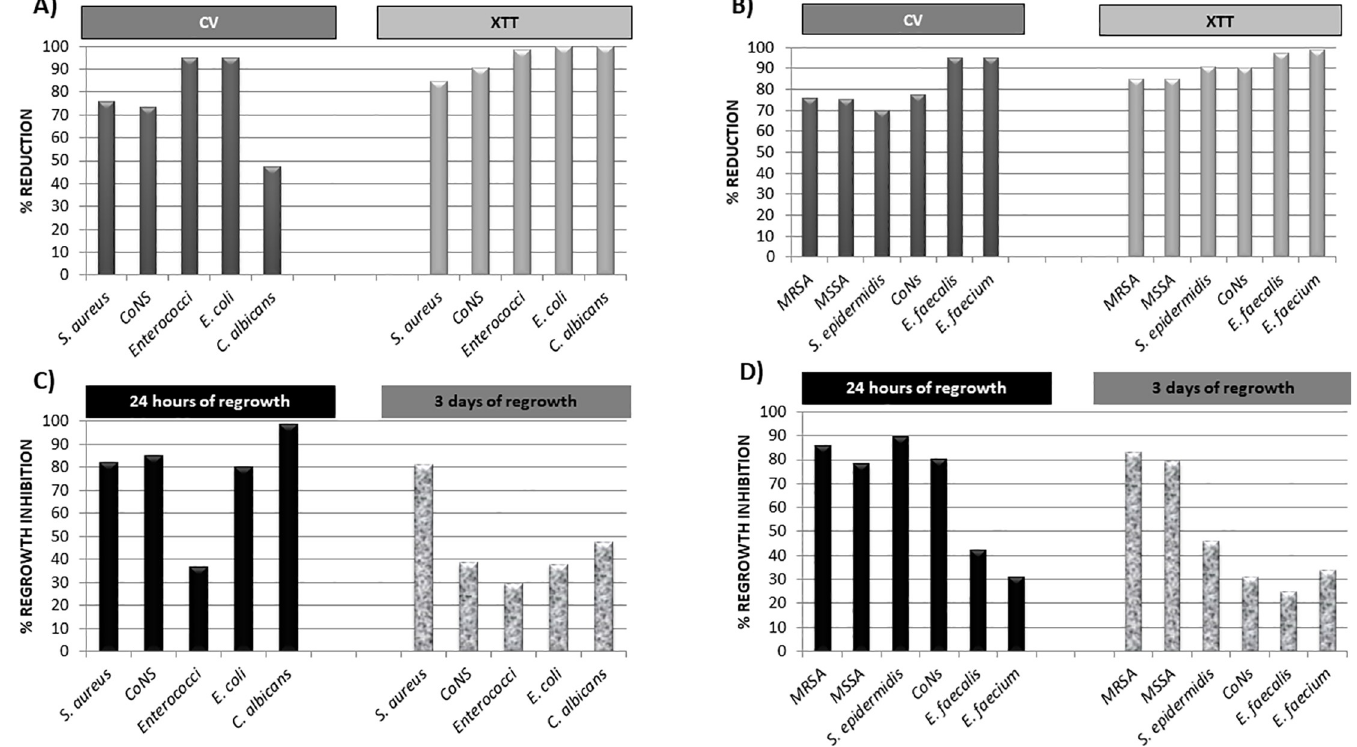
Fig 1. Percentage reduction of biomass and metabolic activity and percentage of regrowth inhibition of biofilms after 72-hour treatment of 40% ethanol combined with 60 international units (IU) of heparin. A) Overall percentage reduction in biomass and metabolic activity after 72-hour treatment with heparinized 40% ethanol lock solution. B) Percentage reduction in biomass and metabolic activity after 72-hour treatment with heparinized 40% ethanol lock solution according to species. C) Overall percentage of regrowth inhibition within 24 hours and 72 hours after 72-hour treatment with heparinized 40% ethanol lock solution. D) Percentage of regrowth inhibition within 24 hours and 72 hours after 72-hour treatment with heparinized 40% ethanol lock solution according to species. CV , crystal violet; XTT, 2,3-Bis-(2- methoxy 4-nitro-5-sulfophenyl)-2H-tetrazolium5-carboxanilide salt; CoNS , coagulase-negative staphylococci; MRSA, methicillin-resistant Staphylococcus aureus ; MSSA, methicillin-susceptible Staphylococcus aureus .